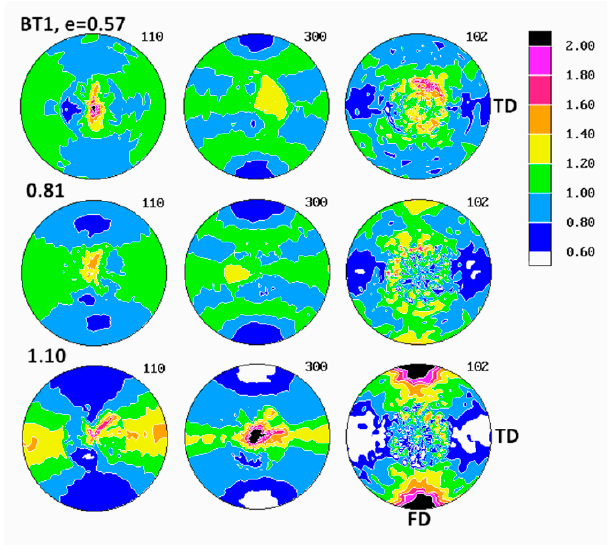
Figure 11. Selected normalized pole figures of the (110) (300) and (102) crystallographic planes (Form I) determined for samples of B1 homopolymer drawn in uniaxial tension to the true strain indicated.